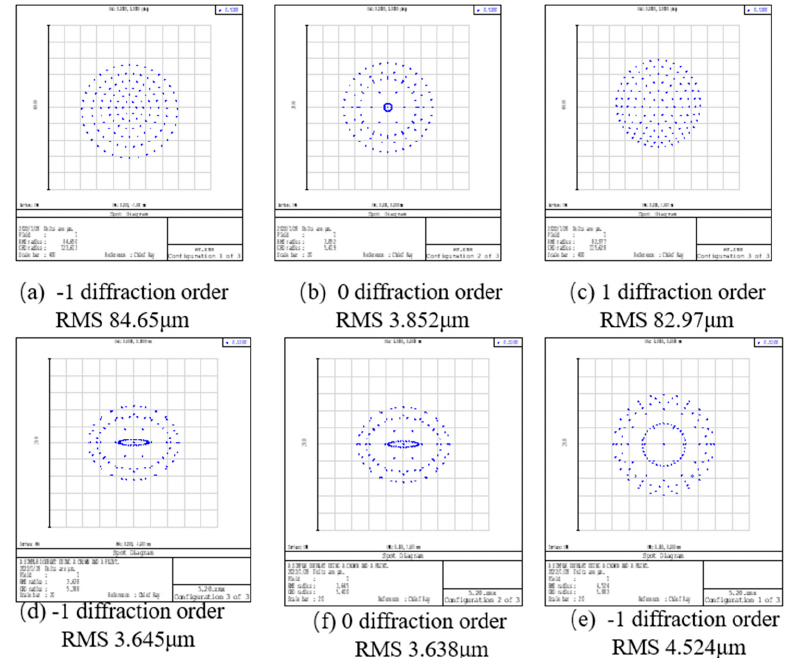
Figure 5. Point column diagram in three orders for the 3D chromatography microscope system before and after aberration correction. ( a – c ) Point column diagram corresponding to different diffraction levels of unmodified chromatography microscopy system. ( d – f ) Point column diagram corresponding to different diffraction levels of aberrated chromatography microscopy system (compare RMS at the bottom of the diagram).